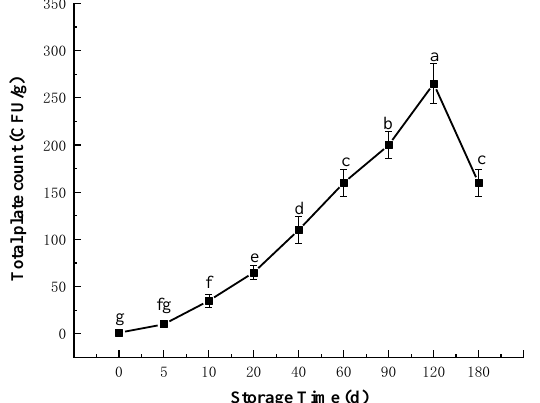
Figure 1. Changes in the TPC of semi-dried rice noodles during storage. Different letters denote significant difference ( p < 0.05).